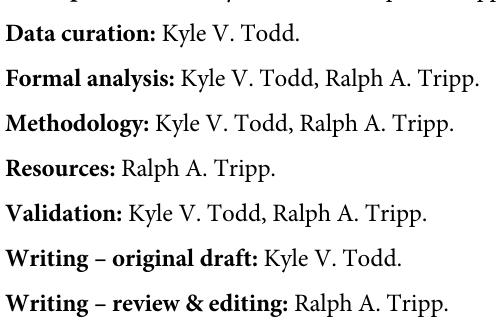
S1 Fig. ExoQuick-isolated exosomes. NanoSight analysis indicated that high concentrations of exosomes (50–150 nm) are contained within HuNoV-infected stool. Extracellular vesicle (EV). S2 Fig. Sample HuNoV g.e. standard curve. S1 Table. Mean Ct values associated with Table 2. S2 Table. Mean Ct values associated with Table